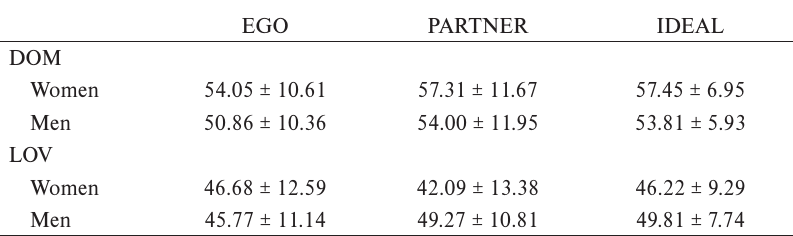
Interpersonal style assessment using ICL Interpersonal check